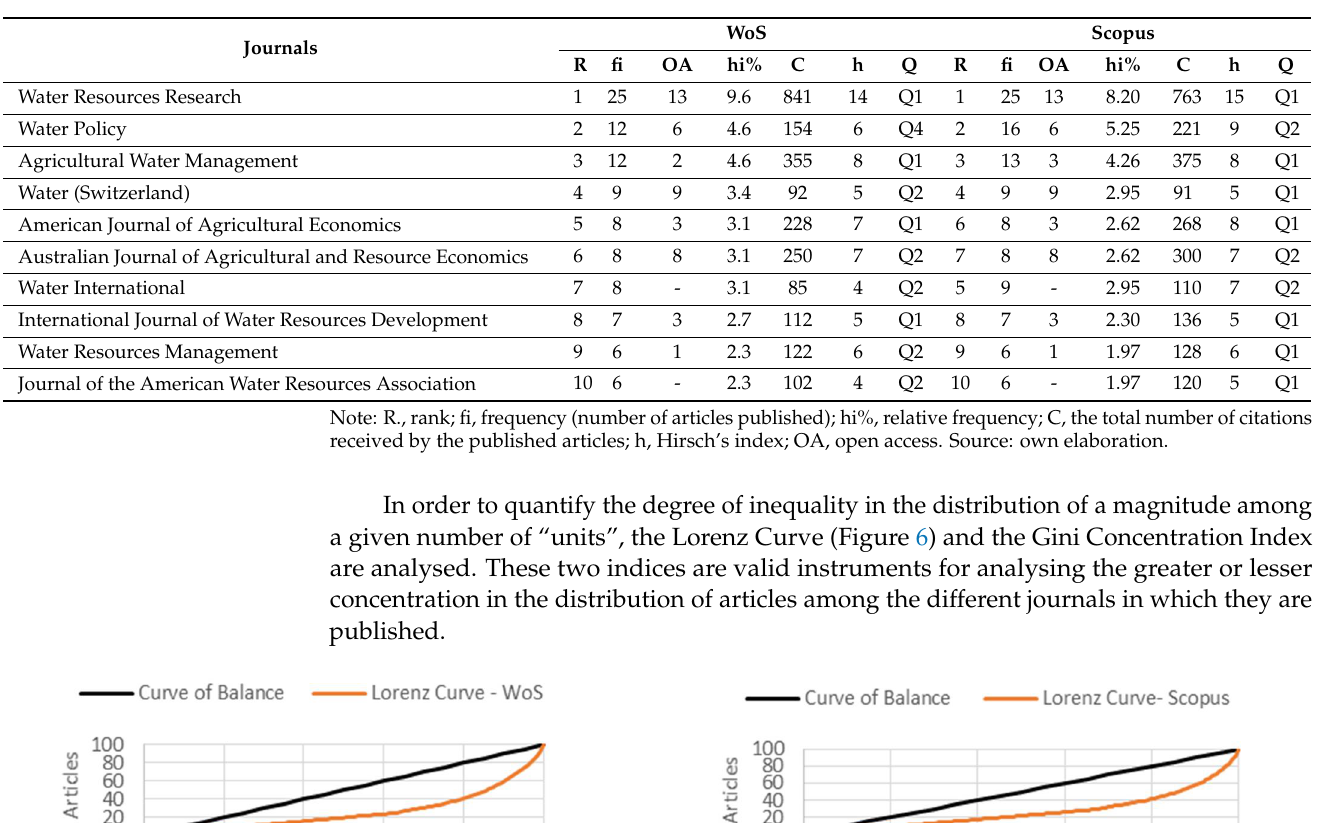
Table 10. Classification of journals according to the number of articles they include about the Water Market.